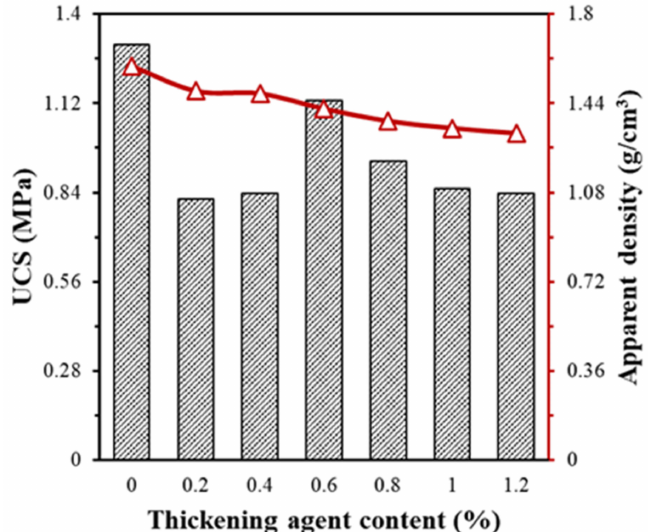
Figure 5. Effect of thickening agent on UCS and apparent density of